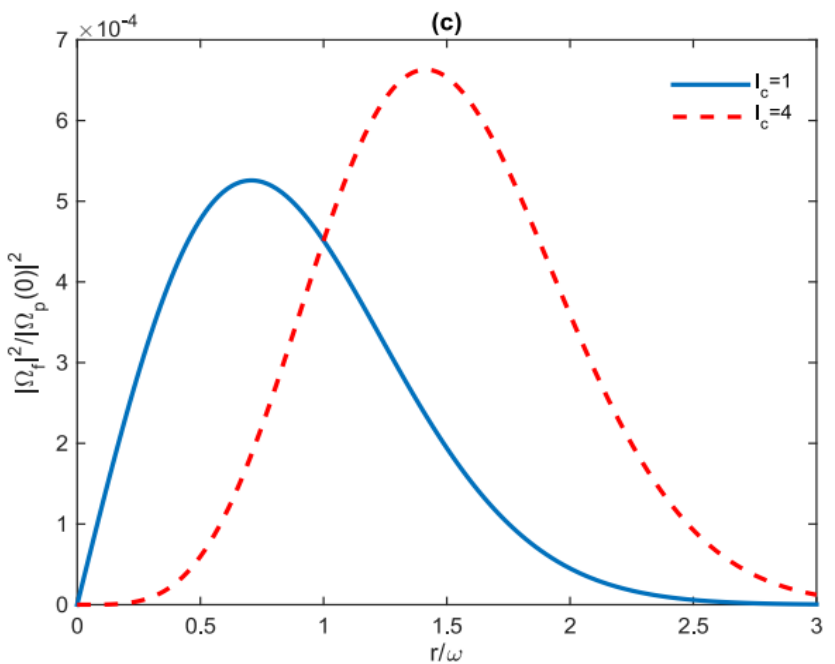
l 4 = (dashed l 1 = (solid line) and Figure 6. FWM efficiency as a function of / r w and for c c 0.9 , 3.1 = =Ω γ ε γ ), part ( b ) line). Part ( a ) corresponds to synergetic EIT and ATS mechanism ( s 30 c 30 Figure 6. FWM efficiency as a function of r / w and for l c = 1 (solid line) and l c = 4 (dashed 2.5 , 4 Ω γ ε γ= = ) and part ( c ) pure EIT mechanism ( l 4 = (dashed l 1 = (solid line) and corresponds to dual ATS regime ( Figure 6. FWM efficiency as a function of / r w and for s 30 c 30 c c line). Part ( a ) corresponds to synergetic EIT and ATS mechanism ( Ω s = 0.9 γ 30 , ε c = 3.1 γ 30 ), 0.8 , 0.1 = =Ω γ ε γ ). The selected parameters are NZ/ 450 γ = and others are as Figure 5. 0.9 , 3.1 = =Ω γ ε γ ), part ( b ) line). Part ( a ) corresponds to synergetic EIT and ATS mechanism ( s 30 c 30 30 part ( b ) corresponds to dual ATS regime ( Ω s = 2.5 γ 30 , ε c = 4 γ 30 ) and part ( c ) pure EIT mechanism s 30 c 30 2.5 , 4 Ω γ ε γ= = ) and part ( c ) pure EIT mechanism ( ( Ω s = 0.8 γ 30 , ε c = 0.1 γ 30 ). The selected parameters are NZ/ γ 30 = 450 and others are as Figure 5. corresponds to dual ATS regime ( s 30 c 30 In Figure 7, we plot the conversion efficiency of the FWM beam for the OAM number 0.8 , 0.1 = =Ω γ ε γ ). The selected parameters are NZ/ 450 γ = and others are as Figure 5. l = (dashed line) vs. the coupling coefficient k ( 1 k k / k = ) l = (solid line) and 4 s 30 c 30 30 In Figure 7, we plot the conversion efficiency of the FWM beam for the OAM number c c 01 03 l c = 1 (solid line) and l c = 4 (dashed line) vs. the coupling coefficient k (k = k 01 /k 03 ) when when the system is in the (a) joint EIT-ATS regime, (b) dual ATS regime, and (c) pure EIT the system is in the (a) joint EIT-ATS regime, (b) dual ATS regime, and (c) pure EIT regime, regime, respectively. We notice that the efficiency conversion for all three regimes is quite l = (dashed line) vs. the coupling coefficient k ( 1 k k / k = ) l = (solid line) and 4 respectively. We notice that the efficiency conversion for all three regimes is quite sensitive sensitive to the coupling factor k. However, increasing the coupling factor k reduces the c c 01 03 to the coupling factor k. However, increasing the coupling factor k reduces the efficiency of efficiency of energy conversion. energy conversion.